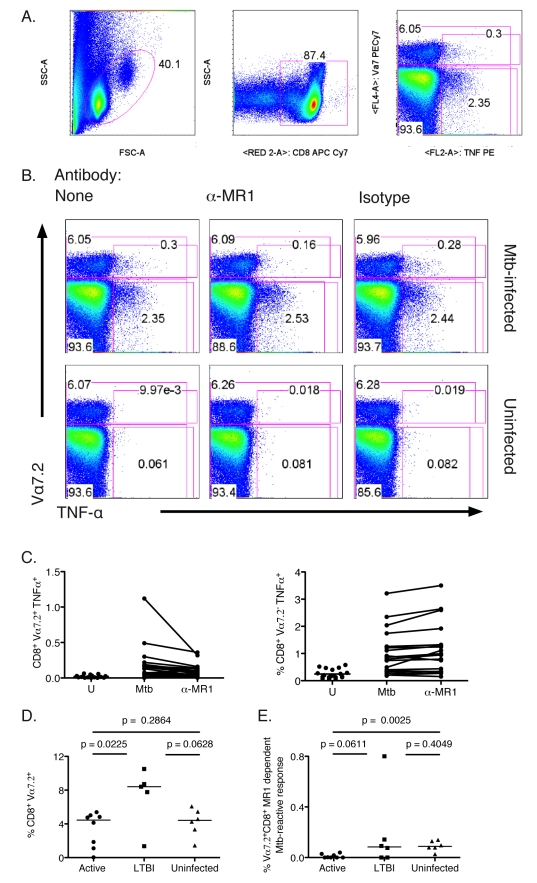
Ex vivo analysis of Mtb-reactive MAIT cells from human peripheral blood CD8+ T cells.T cells were isolated from PBMC using the negative pan-T cell isolation kit and then depleted of CD4+ T cells. The resulting T cells were incubated overnight with A549 cells that were either Mtb-infected (moi 30) or left uninfected in the presence of no, anti-MR1, or IgG2a control antibody. Golgi Stop was added for the final 6 h of the assay. Cells were surface stained for expression of the Vα7.2 TCR then fixed and permeabilized before staining for TNF-α and CD8 expression. Controls performed to test for specific TNF-α staining showed no background responses (unpublished data). (A) Gating strategy: lymphocyte gate (left), CD8 gate (middle), Vα7.2 (y-axis), and TNF-α expression (x-axis) of the CD8 gate (right). The number on the upper left of the right panel represents the frequency of CD8+ T cells that expressed the Vα7.2 TCR. The number in the box on the right represents the frequency of CD8+ T cells that produced TNF-α in response to target cells. (B) Representative FACS analysis showing the conditions tested in the assay: Mtb-uninfected or infected A549 cells in the presence of anti-MR1 antibody (26.5) or IgG2a isotype control (2.5 µg/ml each). (C) Frequency of CD8+ cells that produced TNF-α in response to uninfected, Mtb-infected, or MR1-blocked Mtb-infected A549 cells that either coexpressed the Vα7.2 TCR (left) or not (right). (D) Frequency of CD8+ T cells that expressed the Vα7.2 TCR. Statistically significant differences were observed between the active and LTBI groups. (E) Frequency of MR1-blocked CD8+ T cells that coexpressed Vα7.2 and TNF-α in response to Mtb-infected cells. Statistically significant differences were observed between the active and uninfected groups. Horizontal lines in (D) and (E) represent medians. The nonparametric Mann-Whitney one-tailed t-test was used to assess statistical significant differences between groups.